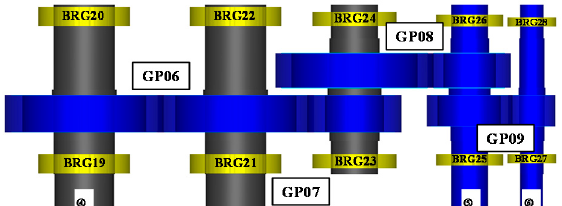
Appl. Sci. 2020 , 10 , x FOR PEER REVIEW Figure 7. Layout of auxiliary gearbox #1. Figure 7. Layout of auxiliary gearbox #1.